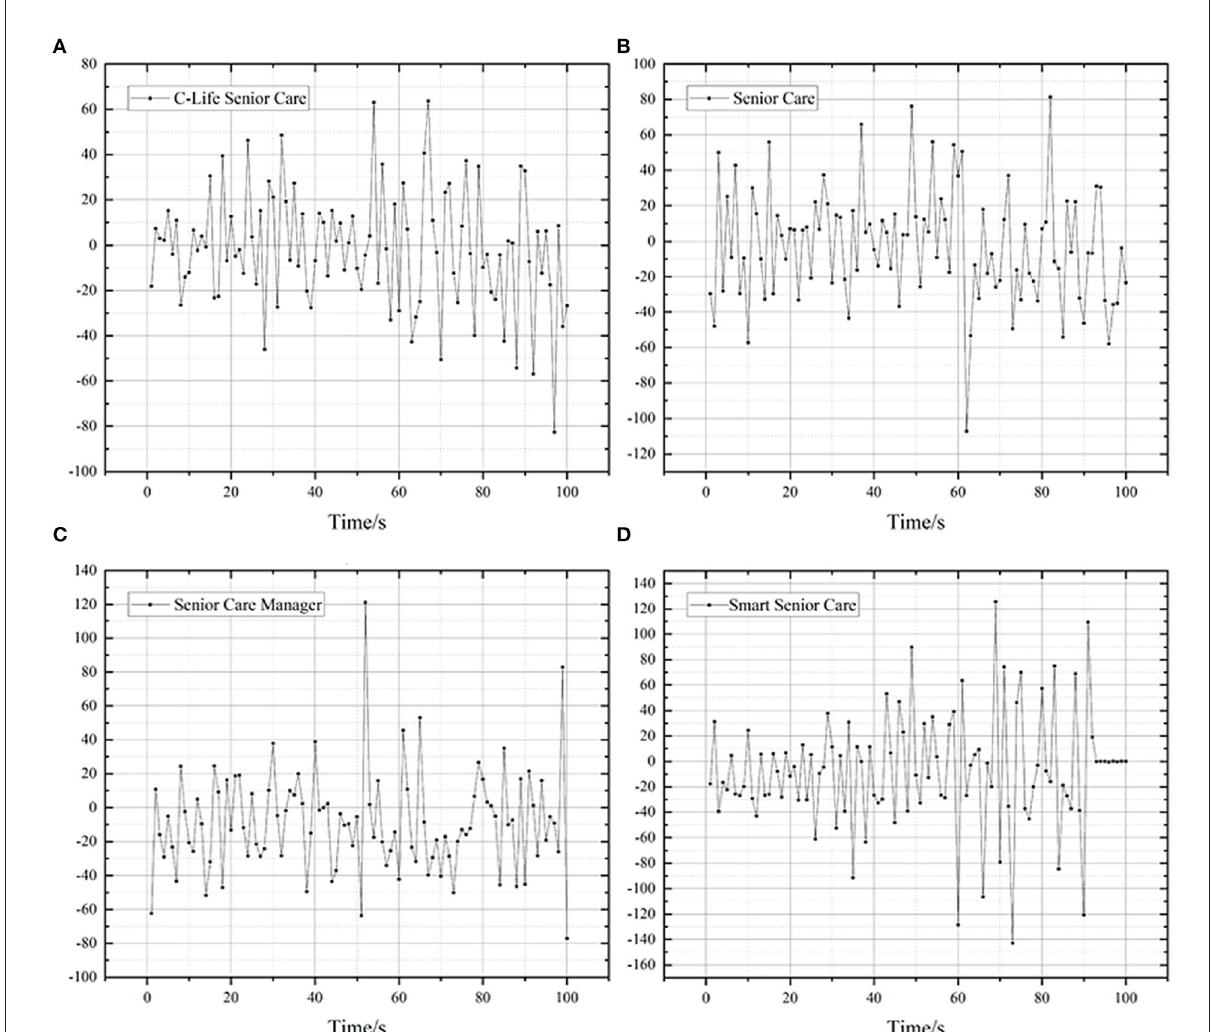
FIGURE4 Mean heart rate variability of the four products. (A) C-Life Senior Care, (B) Senior Care, (C) Senior Care Manager, (D) Smart Senior